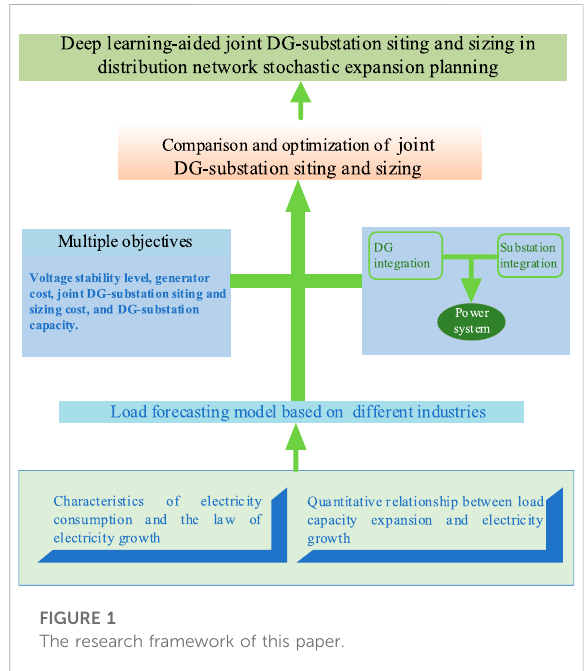
FIGURE 1 The research framework of this